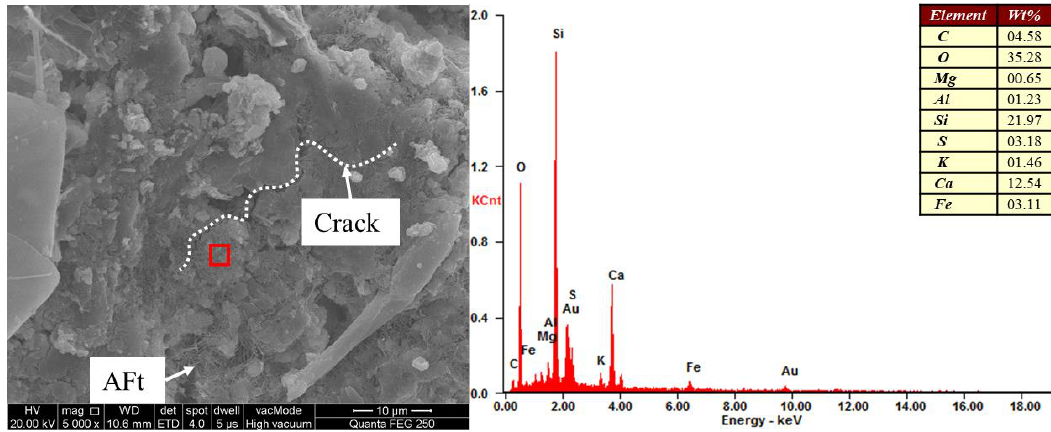
Figure 12. SEM images of A2 and A8 cured for 28 days.